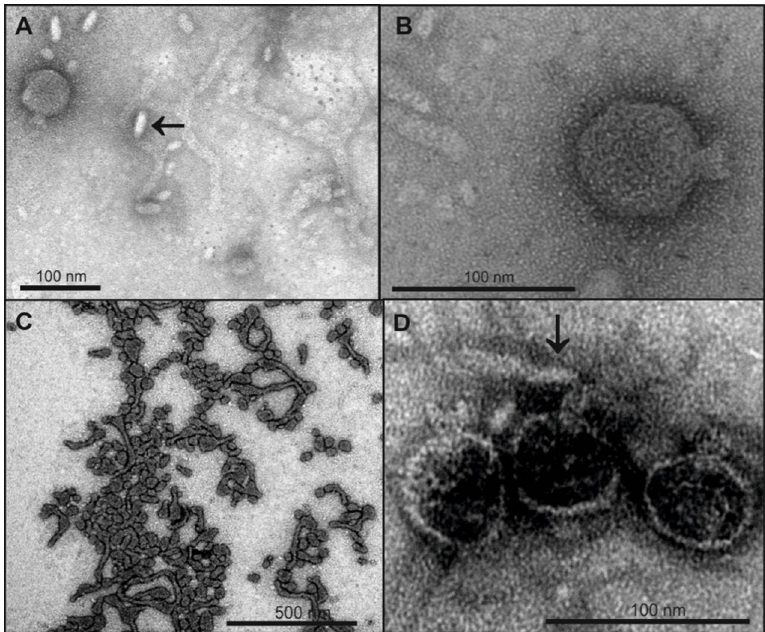
Figure 4. Legend: TEM micrographs of phage HK620 before and after incubation with non-host E. coli LPS. 1 × 10 10 pfu mL −1 HK620 particles were stained with 1% ( w / v ) uranyl acetate after overnight incubation at 37 °C with 0.24 mg mL −1 LPS from E. coli IHE3042 (O18A1) ( A , B ) or E. coli DSM 10809 (O18A) ( C , D ). For IHE3042 (O18A1) with short O-antigen chains mainly small LPS structures are visible (arrow in A ) and HK620 particles are not attached to these structures ( B ), whereas on DSM 10809 (O18A) LPS with longer O-antigen chains empty HK620 particles are attached ( D , arrow).